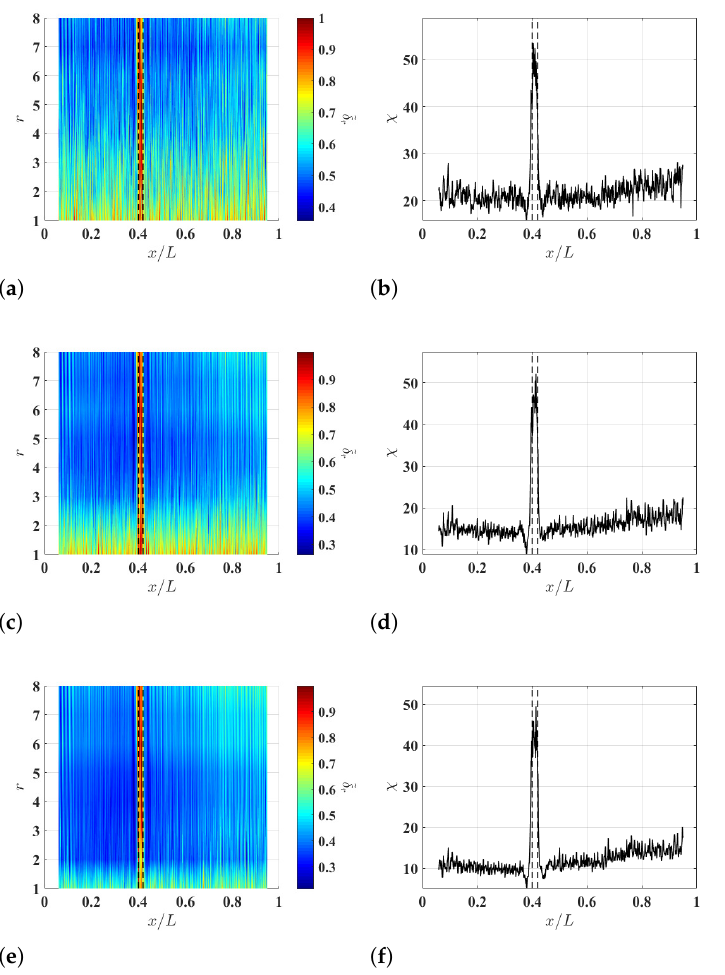
Figure 6. ( a ) Multi-resolution auxiliary TSCDI ˜ δ r associated with the noise-contaminated waves with signal-to-noise ratios of ( a ) 30 db, ( b ) 40 db and ( c ) 50 db, which are calculated with r = 1,2, . . . ,8 and ξ = 10%, and auxiliary CDI χ associated with ( d ) ˜ δ r in ( a ), ( e ) ˜ δ r in ( a ), and ( f ) ˜ δ r in ( c ). Locality and extent of the damage are indicated by two dashed